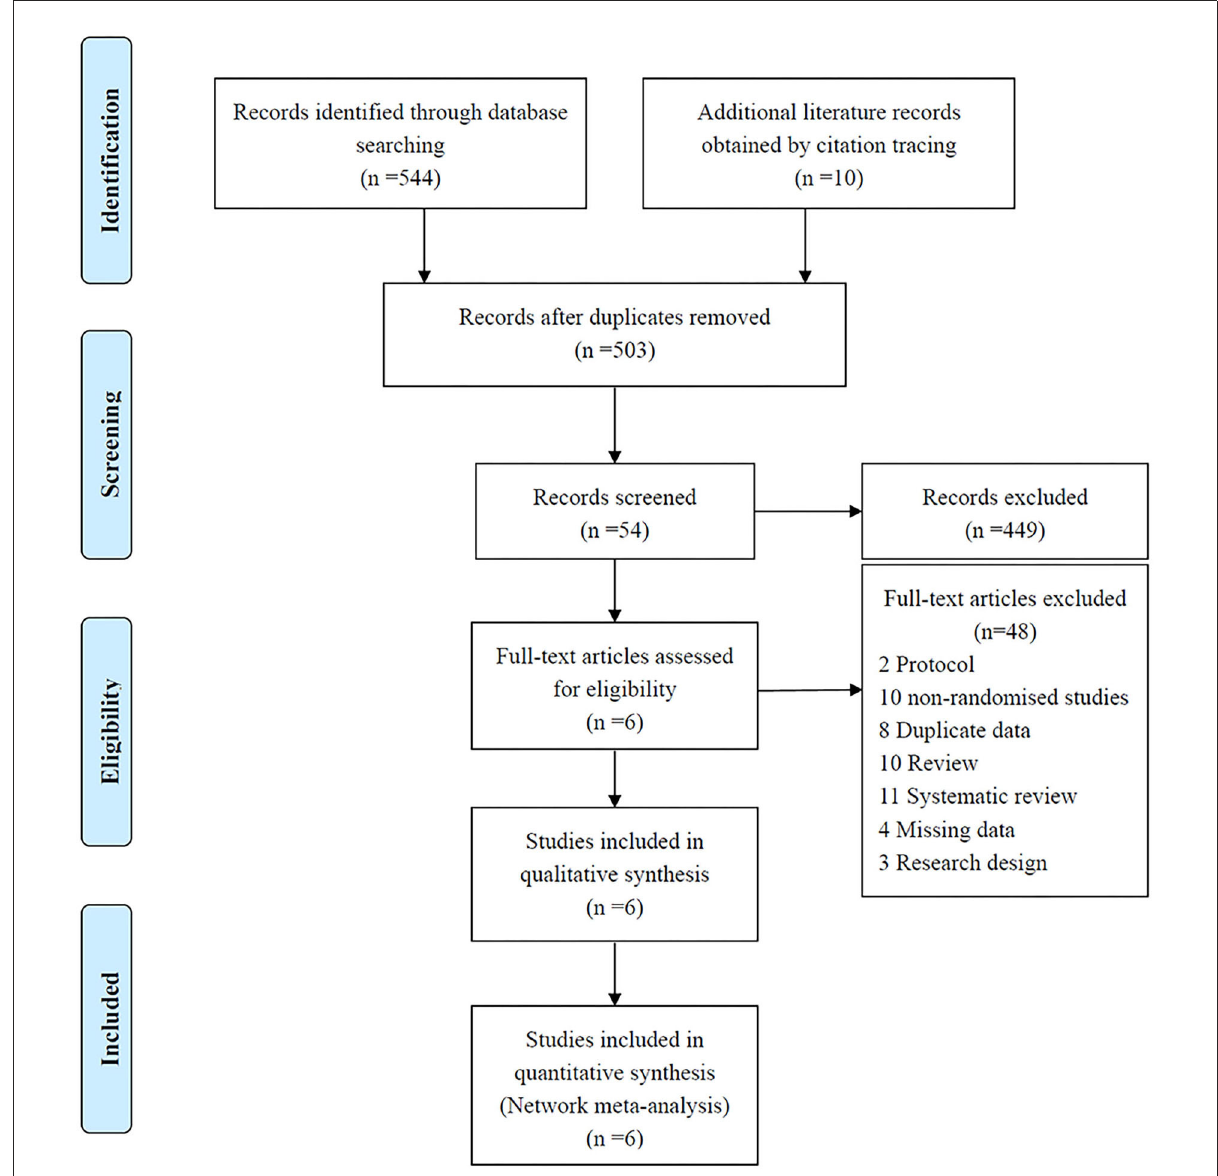
FIGURE1 Flowchart of literature identification, review, and